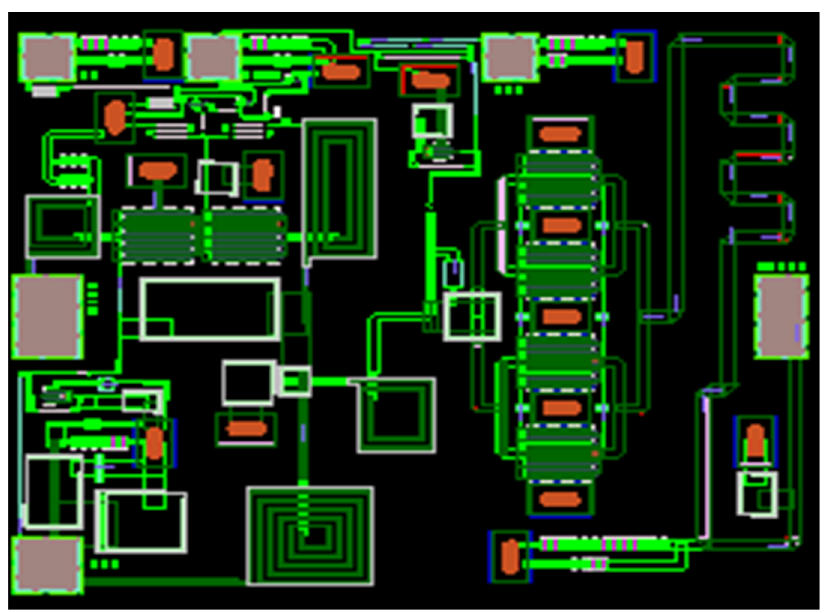
Figure 1. The circuit schematic of this MMIC PA.